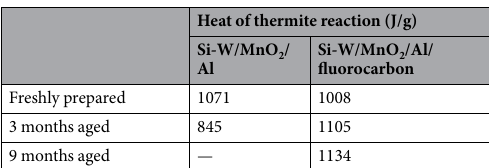
Heat of thermite reaction (J/g)